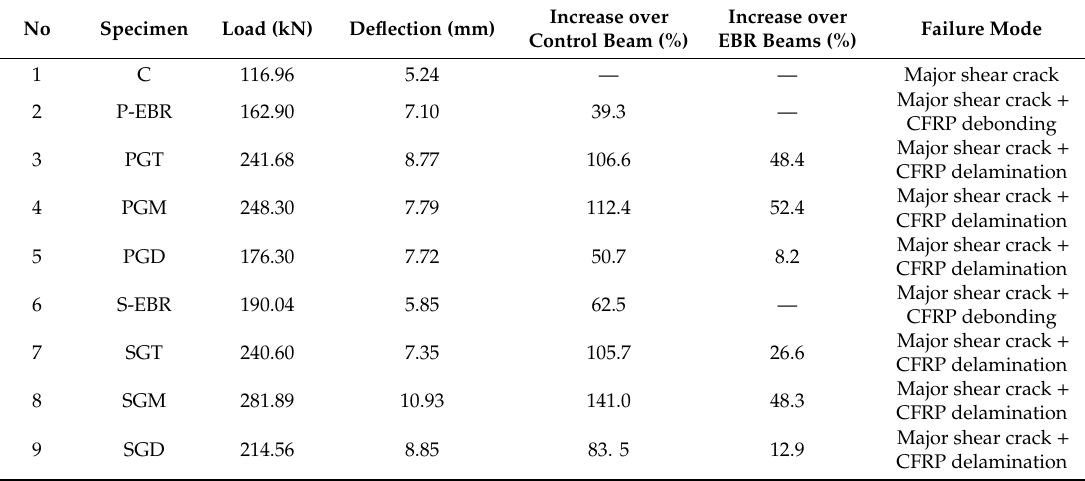
Table 3. Summary of experimental